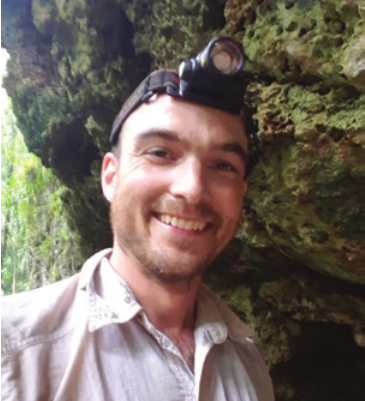
Figure 1 Ceri Shipton, the IoA’s new Lecturer in Palaeolithic